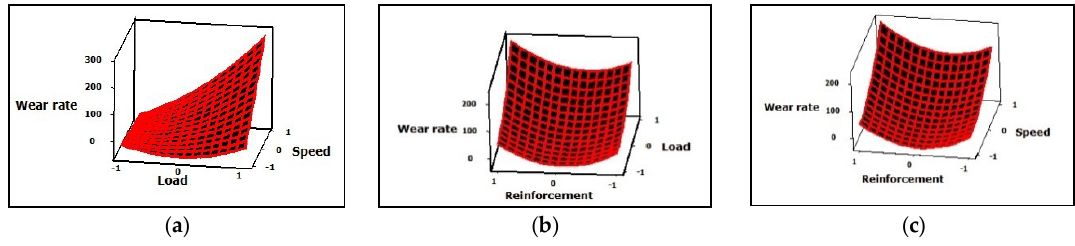
Figure 4. ( a ) Variation of wear rate with speed and load; ( b ) Variation of wear rate with load and reinforcement ( c ) Variation of wear rate with speed and reinforcement.